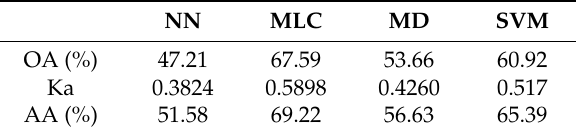
Table 3. Initial classification results acquired by different classifiers for the Pavia University